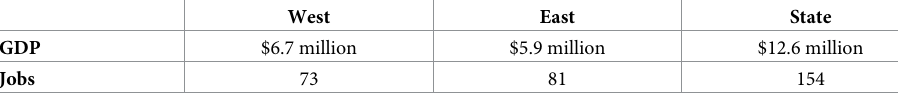
Table 4. Five-year regional and statewide impacts of feed lost due to